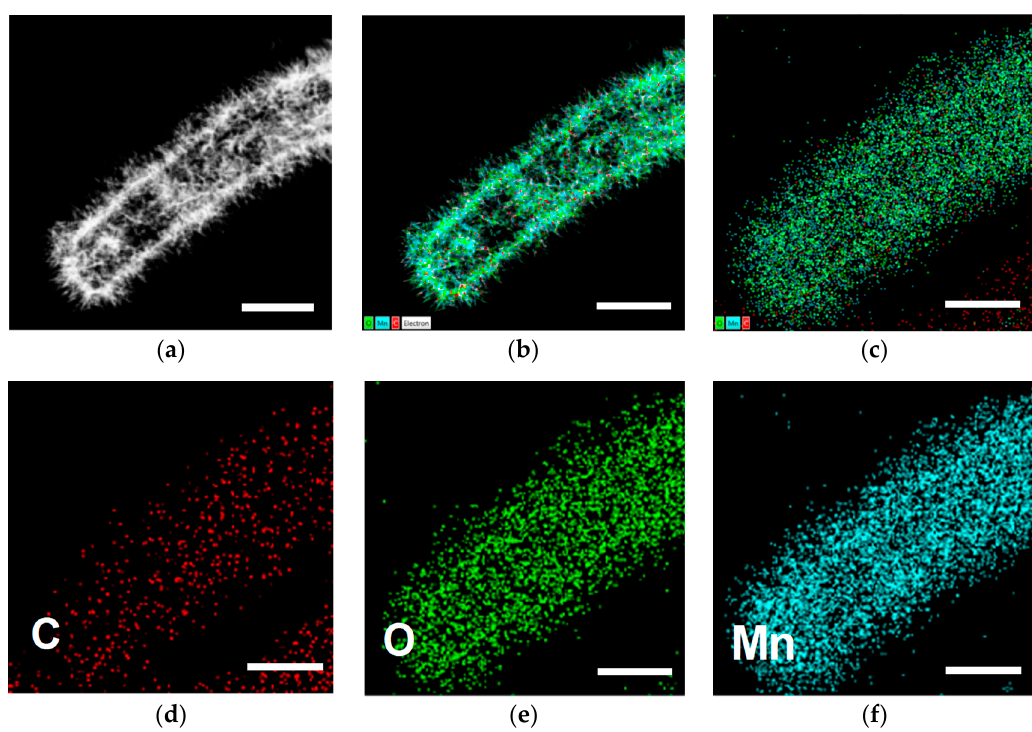
Figure 4. ( a – c ) STEM images of an individual MnO 2 -carbon-40.15% composite with the corresponding EDS elemental mapping of ( d ) C, ( e ) O, and ( f ) Mn. Scale bars = 300 nm.